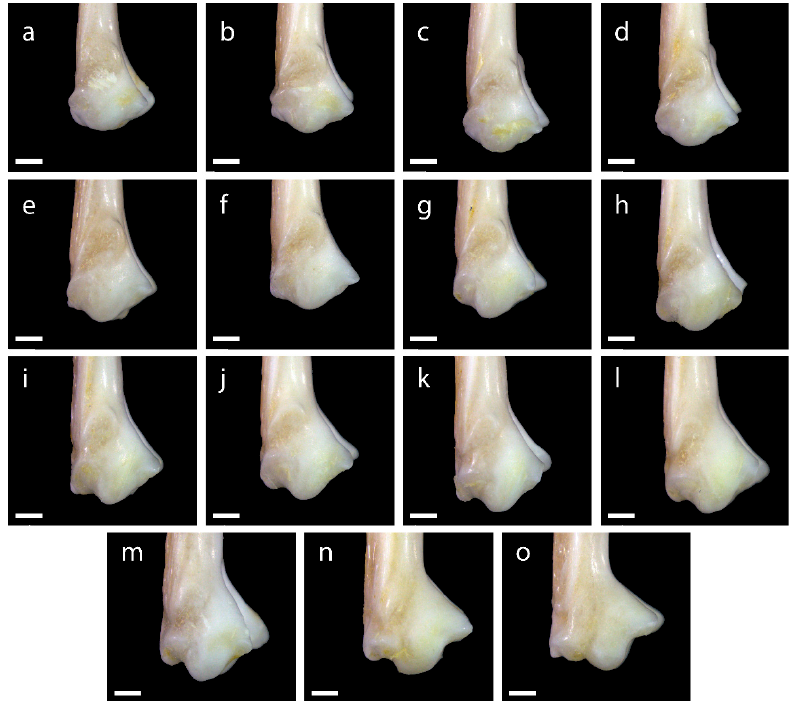
Figure A12. Microscopic images of the lateral left view of the pinnules of P. bichir PO2. The images ( a – o ) correspond to the 1st, 2nd, 3rd, 4th, 5th, 6th, 7th, 8th, 9th, 10th, 11th, 12th, 13th, 14th, and 15th pinnules, respectively. Scale = 1 mm.